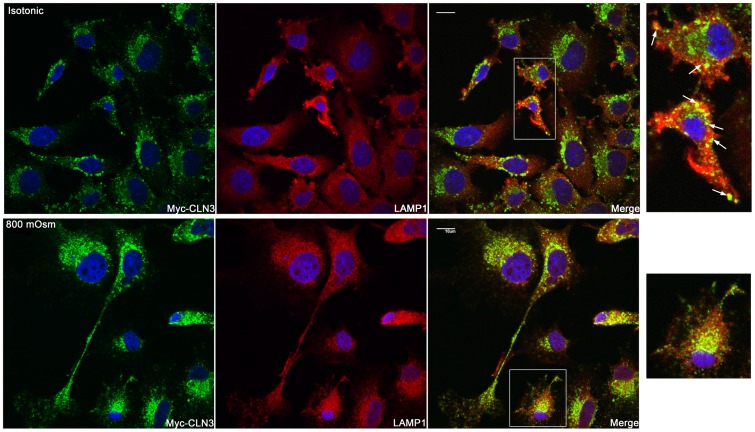
Osmotic stress enhances the lysosomal localization of myc-CLN3.BHK clone 19 myc-CLN3-expressing cells were grown on poly-D-lysine coated coverslips either under isotonic (300 mOsm) or hyperosmotic conditions. Osmolarity was increased at 100 mOsm intervals to 800 mOsm by the addition of NaCl/urea. After being exposed to 800 mOsm for 24 hours, cells were fixed, permeabilized and immunofluorescently stained for the myc-tag (to detect myc-CLN3; green) and for the lysosomal marker, LAMP1 (red). Under isotonic conditions, a portion of myc-CLN3 is localized to lysosomes. In the merged images yellow indicates the lysosomal localization of myc-CLN3. Myc-CLN3 distribution in lysosomes is enriched at 800 mOsm. The white-framed areas of the merged images are enlarged at the right side of the figure to highlight the osmotic stress-induced increase in the lysosomal localization of myc-CLN3. Arrows in the enlarged images taken from isotonic cultures point to myc-CLN3 localized in lysosomes. Images were taken with a confocal microscope. Scale bars indicate 10 µm.